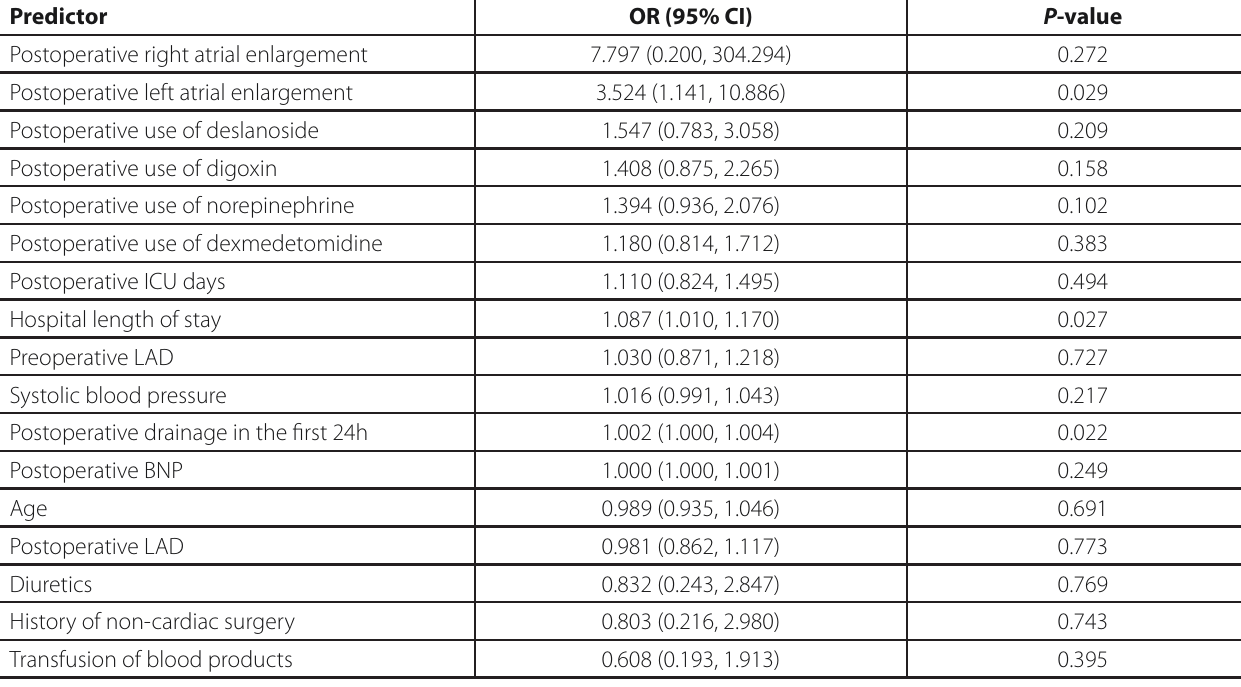
Table 2. Multivariable predictors of new-onset POAF.